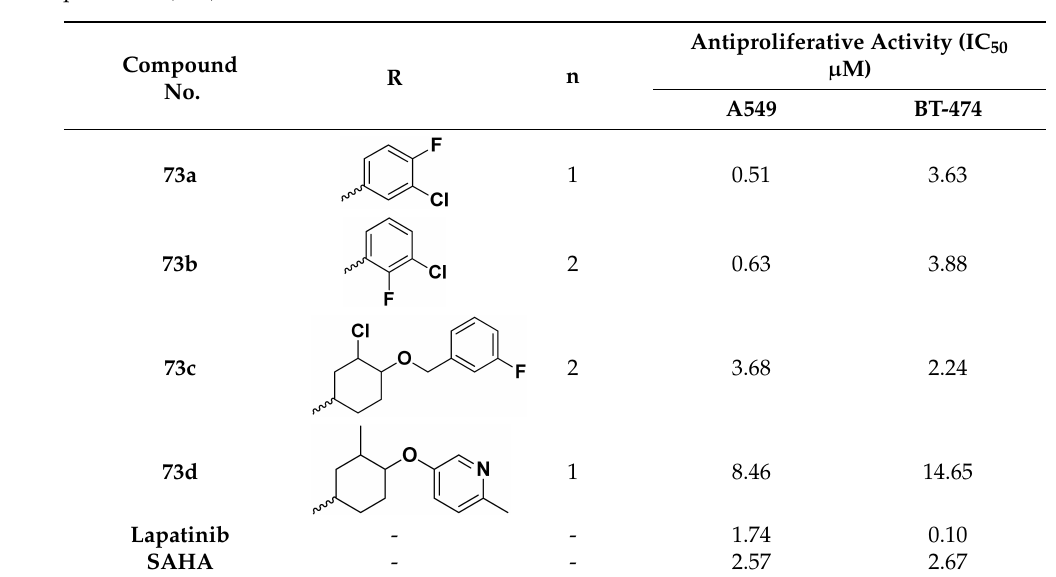
Figure 70. Structure of hydroxamic acid based 4 ‐ aminoquinazolin derivatives ( 73 ). Table 58. In vitro cytotoxic activities of hydroxamic acid based 4-aminoquinazolin hybrid com- pounds 73 ( a – d